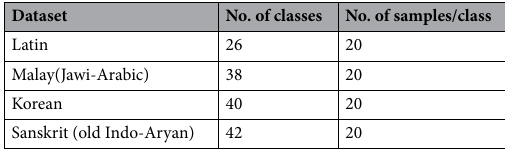
Table 2. Details of the chosen datasets from Omniglot